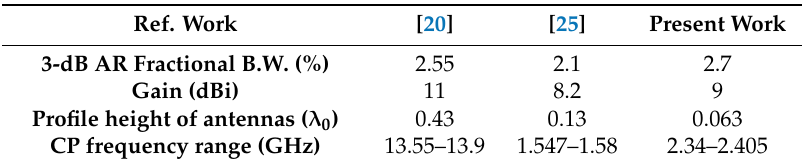
Table 2. Comparison between the performance of the proposed circularly polarized microstrip antennas and a few other reported antennas with circular